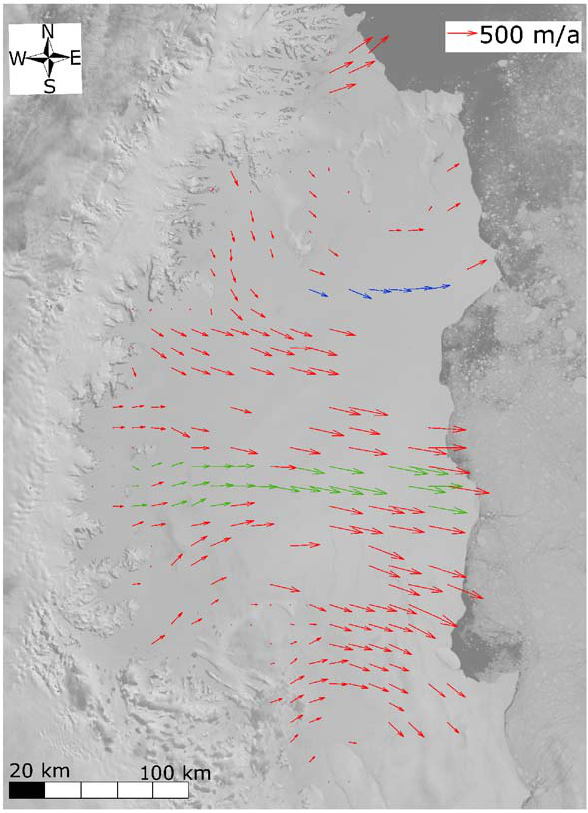
Fig. 3. Average annual velocity between 2002 and 2006 measured with orientation correlation on MODIS images. Blue and green col- ors indicate that these measurements are compared with Landsat measurements. The underlying MODIS image of 2009 is prepro- cessed by Scambos et al.